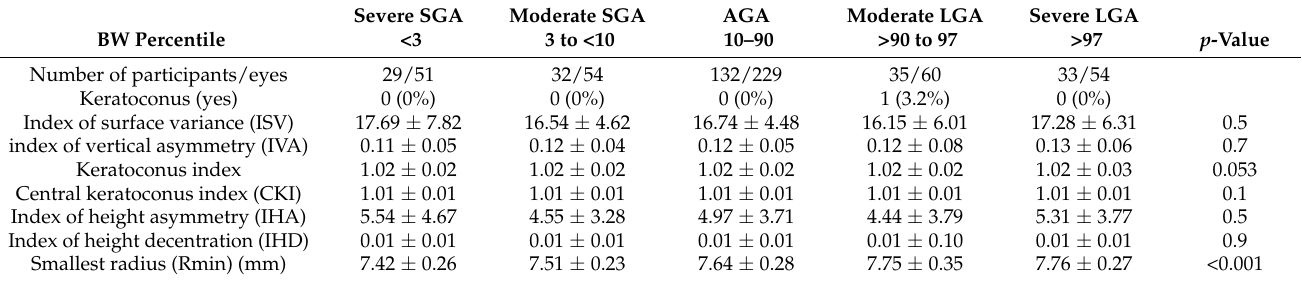
Table 4. Keratoconus indices of each study group.